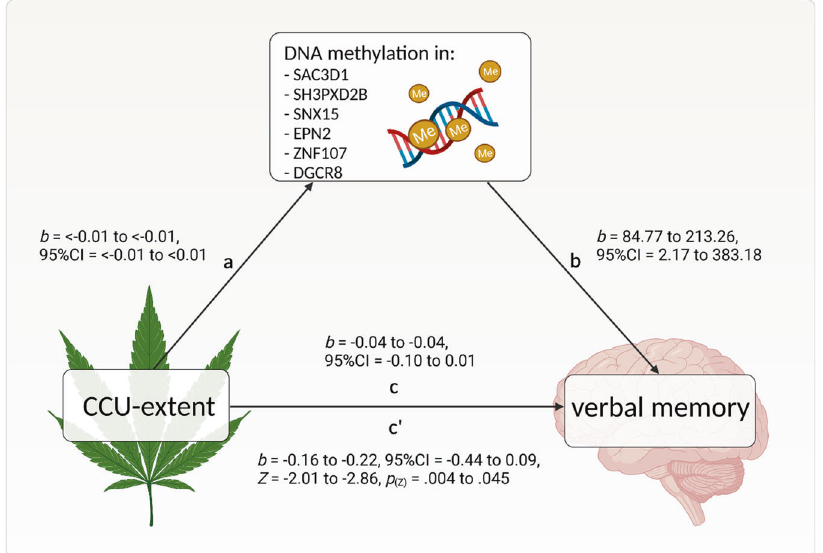
Fig. 3 Mediation effects of six CCU-associated CpG sites on the relationship between CCU-extent and verbal memory. CCU-extent associated impairments in verbal learning (scores in VLMT free recall trial) are mediated via differential methylation patterns of the six CCU- associated CpG sites in SH3PXD2B (Cg17285328), DGCR8 (Cg04904300), ZNF107 (Cg08923376), SNX15;SAC3D1 ( Cg04270414), EPN2 and (Cg23767840) genes. Effect sizes for path a: b = <0.01 to <0.01, path b: b = 84.77 to 213.26, path c: b = − 0.04 to − 0.04 and path c ’ : b = − 0.16 to = 0.004 to 0.045. Please see Tables 5 and 6 for further details. The fi gure was created with − 0.22, p (Z)